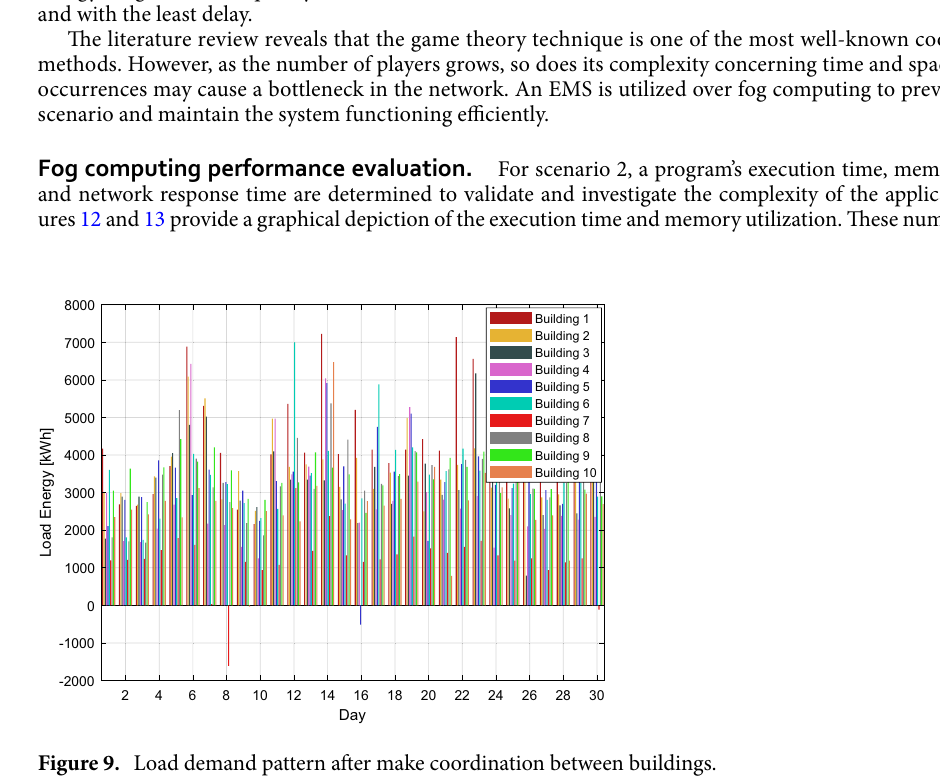
Figure 9. Load demand pattern after make coordination between buildings.